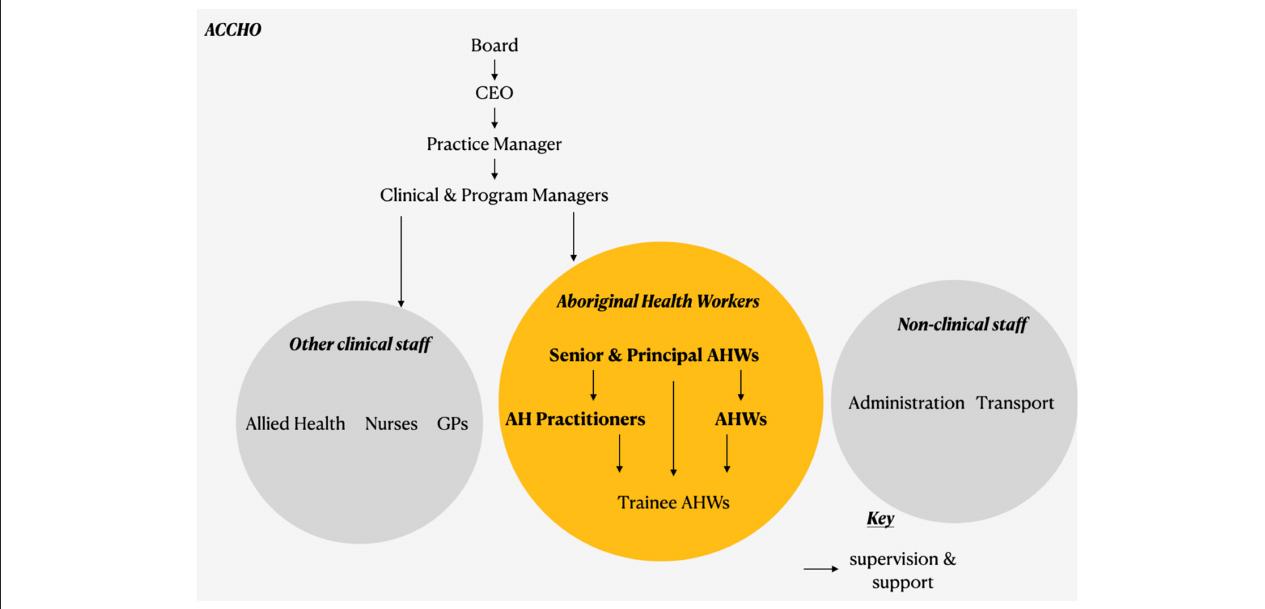
FIGURE4 Position of AHWs in PHC in NSW. This chart summarizes the typical position and governance of AHWs (in the orange circle) within a typical NSW ACCHO. Other health staff are shown in the gray circles. The arrows signify the direction of supervision, starting with the Board. AHW, Aboriginal Health Worker; ACCHO, Aboriginal Community Controlled Health Organisation.